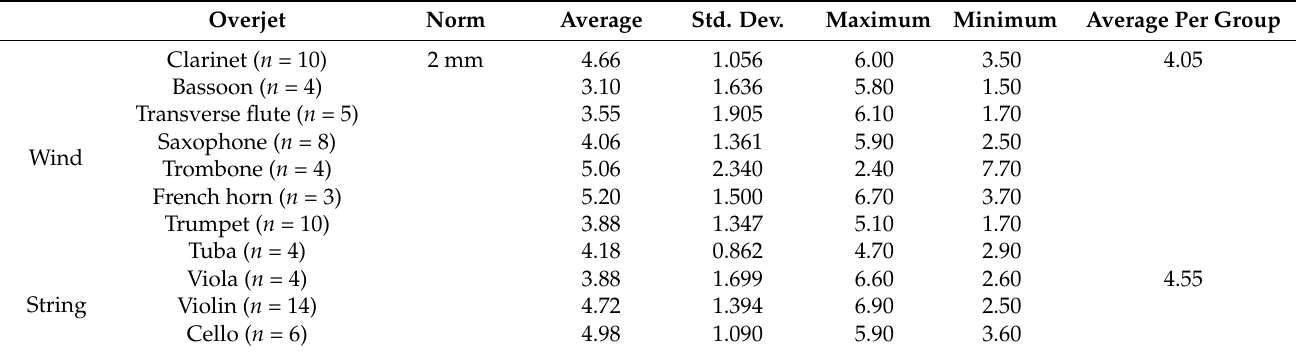
Table 2. Descriptive statistics for the variable